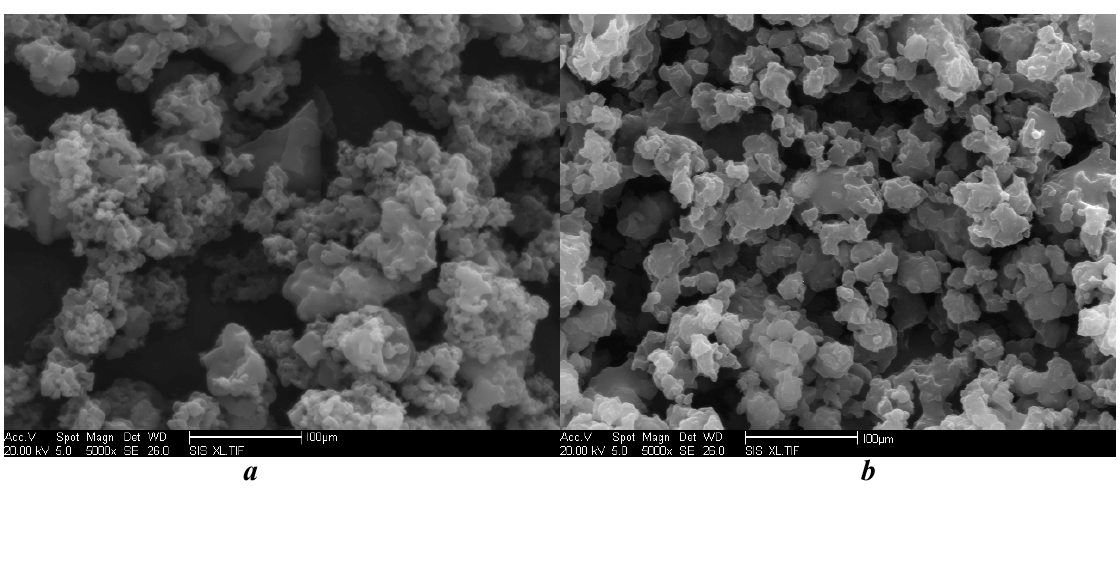
Figure 1. SEM photomicrographs of free transglutaminase ( a ) cross-linked transglutaminase ( b ), polypropylene microporous membrane in the absence of ( c ) and with ( d ) the cross-linked transglutaminase (magnification